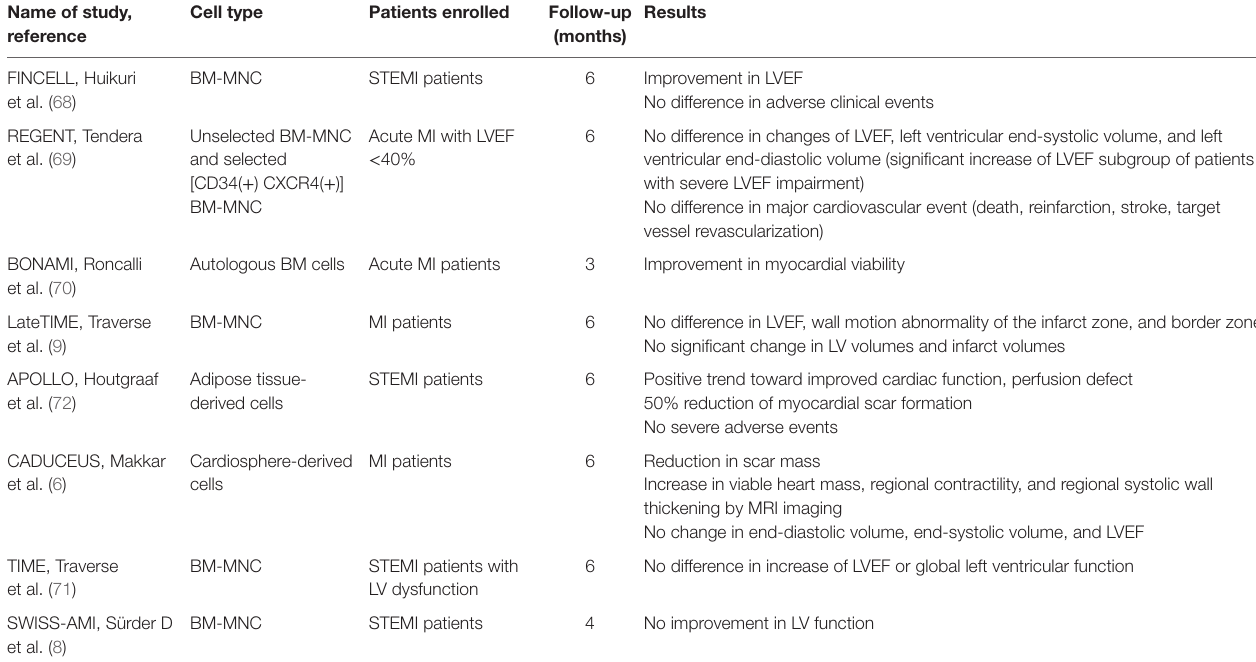
TABLe 1 | Recent human clinical trials for stem cell therapy in